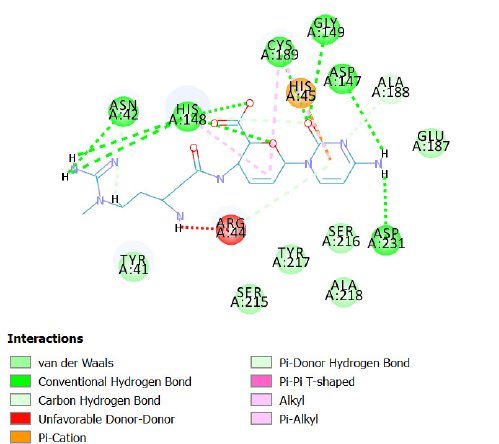
Fig. 2A. 2D diagram showing interactions of Blastici- din S hydrochloride at LGMN catalytic site.